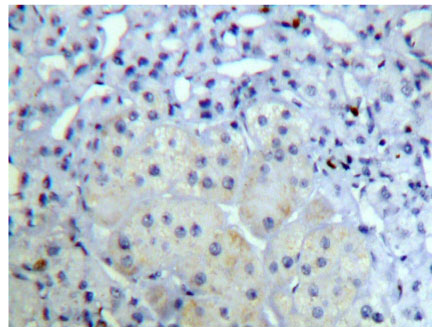
Adrenocortical hyperplasia Ki-67(—) SuperisionTM two footworks